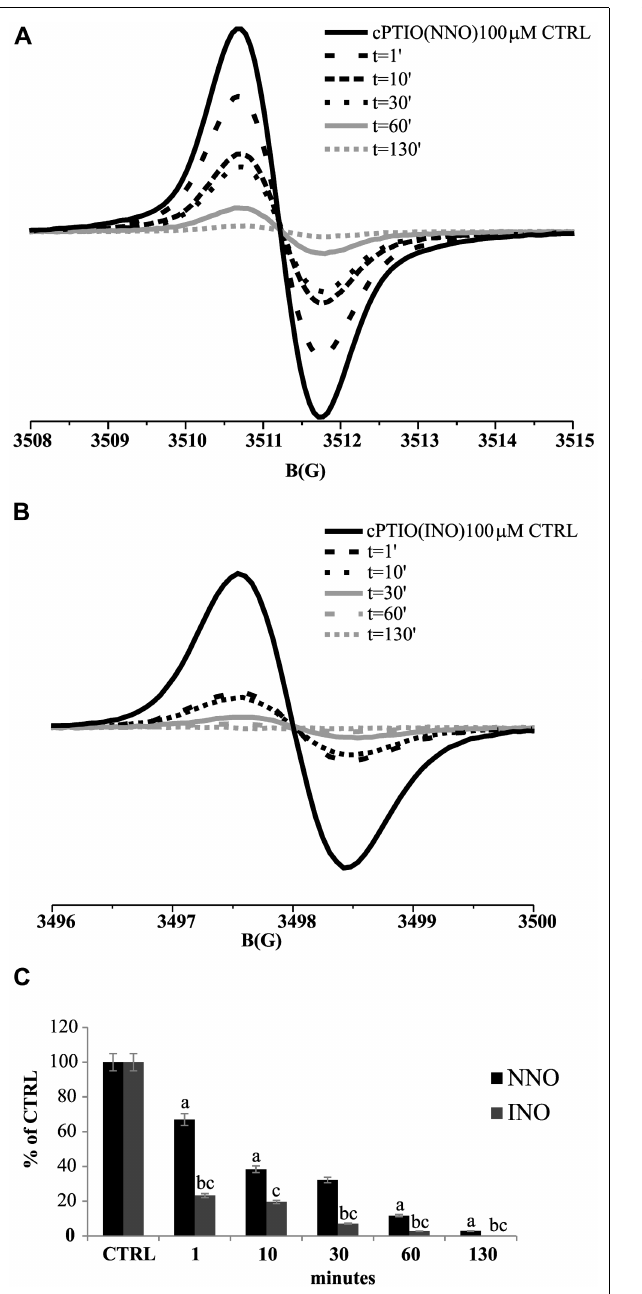
FIGURE 2 |Time dependence of cPTIO(NNO) and cPTIO(INO) EPR signals in suspension cultured cells. Central line of cPTIO(NNO) (A) , and low field, first line of cPTIO(INO) (B) EPR spectra were quantified. In (C) the intensity of EPR signal for each measurement, is presented as percentage of the total signal resulting from measurement of 100 μ M cPTIO(NNO) or (INO) dissolved in water (CTRL) ± SD. cPTIO(NNO) or (INO) was added to the supernatant of 5-day-old Arabidopsis suspension cultured cells and aliquots of the medium were collected at the time points indicated. A Student’s t -test was performed for each experiment and statistically significant data are marked: (a) p < 0.01 cPTIO(NNO) compared with the previous time point, (b) p < 0.01 cPTIO(INO) compared with the previous time point, (c) p < 0.01 cPTIO(INO) compared with cPTIO(NNO) at the same time point.